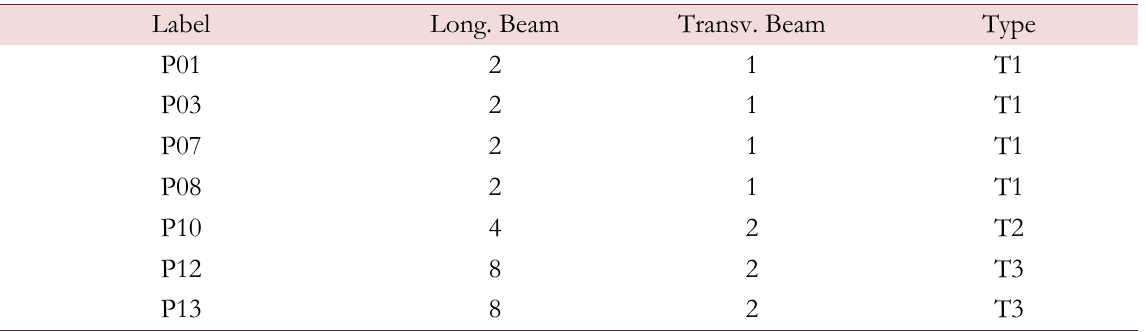
Table 4: Bridge net description.